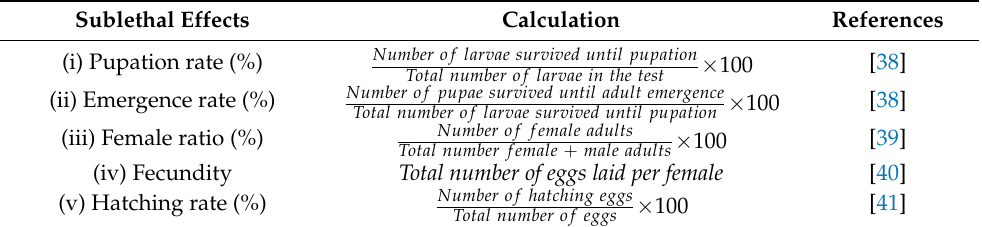
Table 1. Calculation of sublethal effects properties of Plutella xylostella.